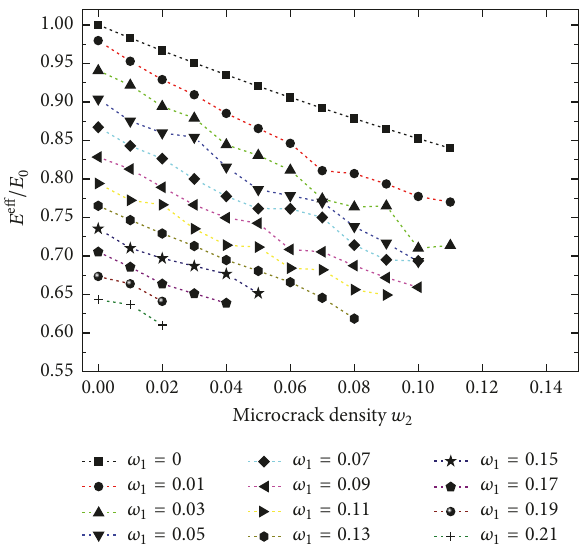
Figure 9: 𝐸 eff /𝐸 0 versus the microcrack’s and microvoid’s density.